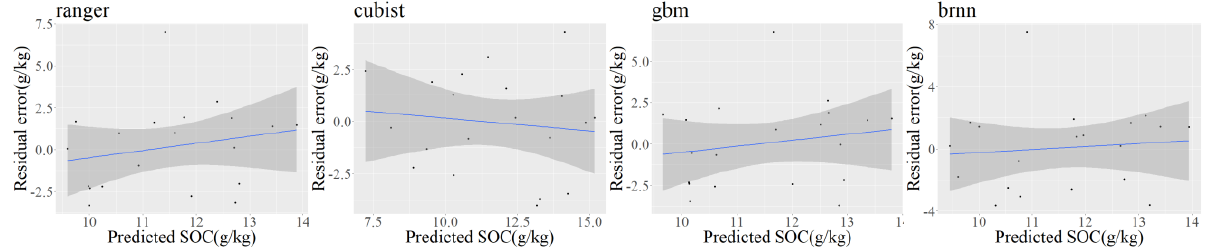
Figure 4. Residual – predicted value fit plot of the ML models: ranger, Cubist, GBM, and BRNN. Note: the shaded area indicates the confidence interval of the fitted line at the 95-percent confidence level.